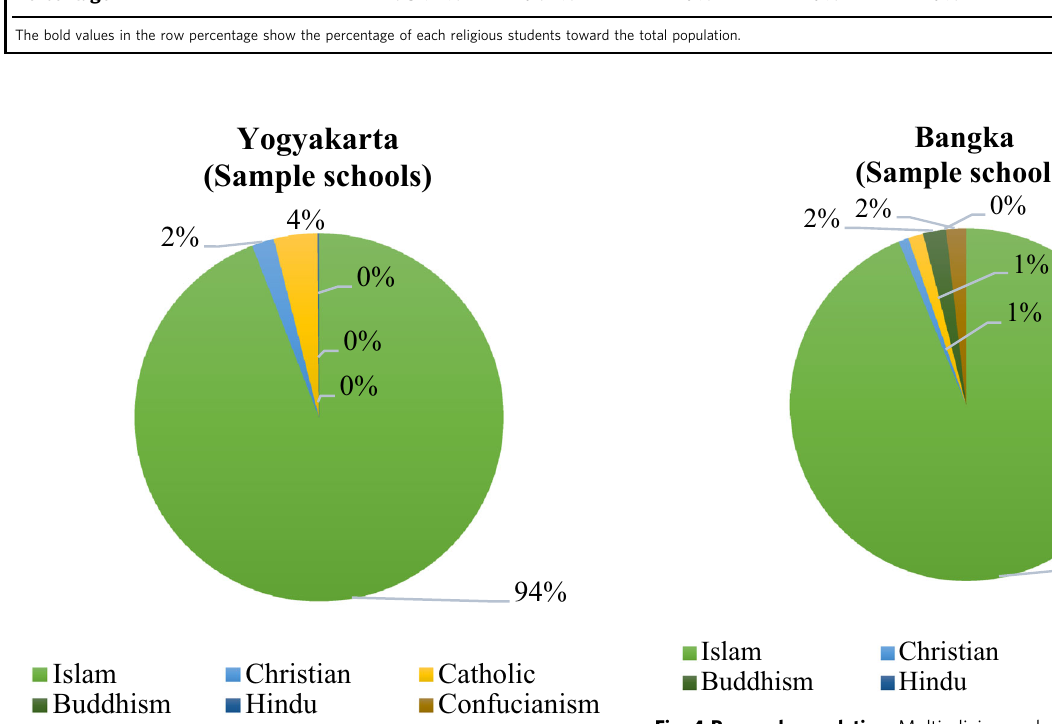
Fig. 3 Research population. Multireligious school samples in Yogyakarta.